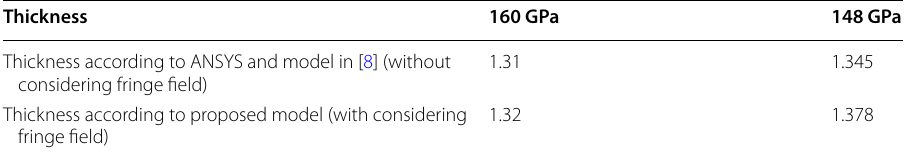
1.31 1.345 1.32